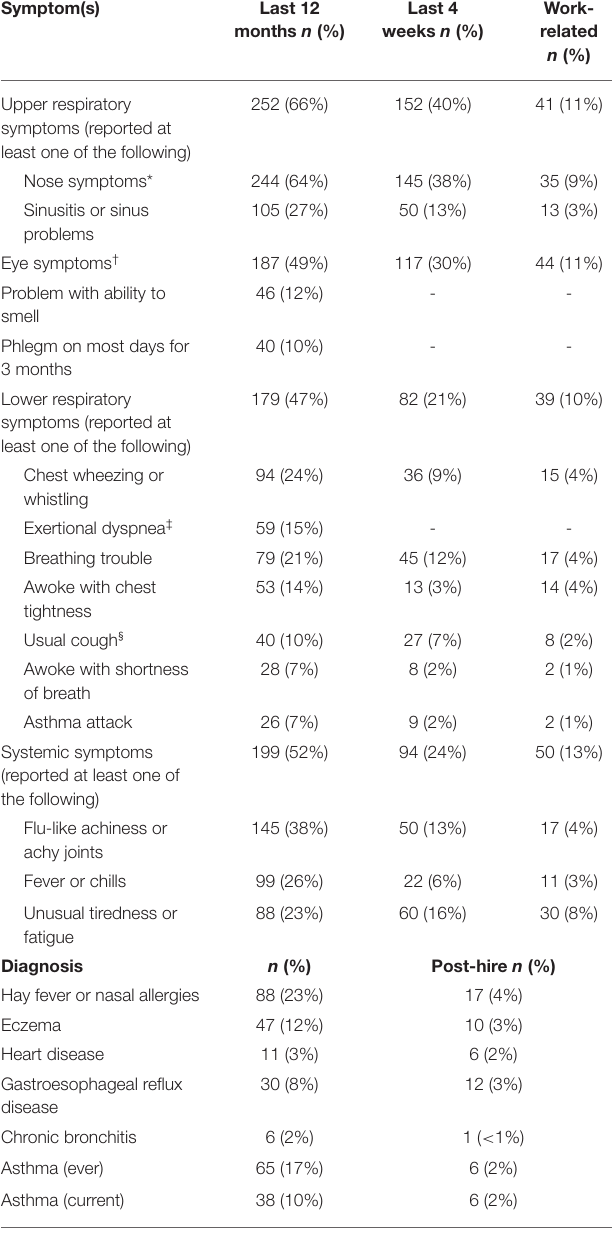
TABLE 2 | Prevalence of reported symptoms and work-relatedness, and self-reported doctor diagnoses and diagnoses post-hire, by workers in 17 coffee roasting and production facilities, N =